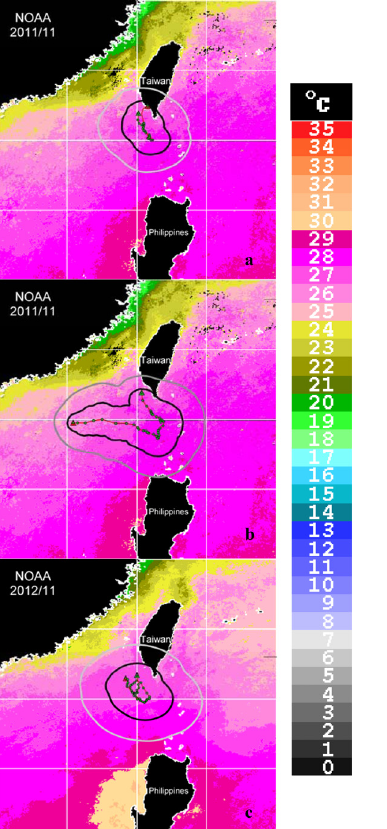
Fig. 5. Deployment locations (fx1), pop-up endpoint positions (fx2) and movement routes of 3 yellow fi n tuna with tags D (a), F (b), and I (c). The dark and light grey ellipses indicate the 50% and 95% con fi dence intervals of trajectory route. The monthly satellite-derived SST images from NOAA/AVHRR shows the hydrotropic features in November 2011 (a), (b), and November 2012 (c).